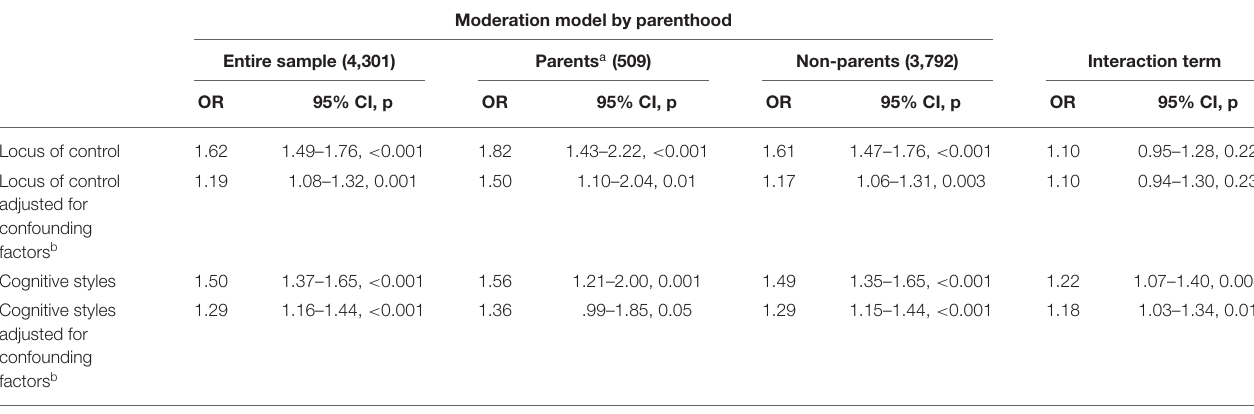
TABLE 3 | Unadjusted and adjusted odds ratio for adult depression according to continuous scores of locus of control and negative cognitive styles and stratified by parental status in multiple imputed datasets. Moderation model by parenthood